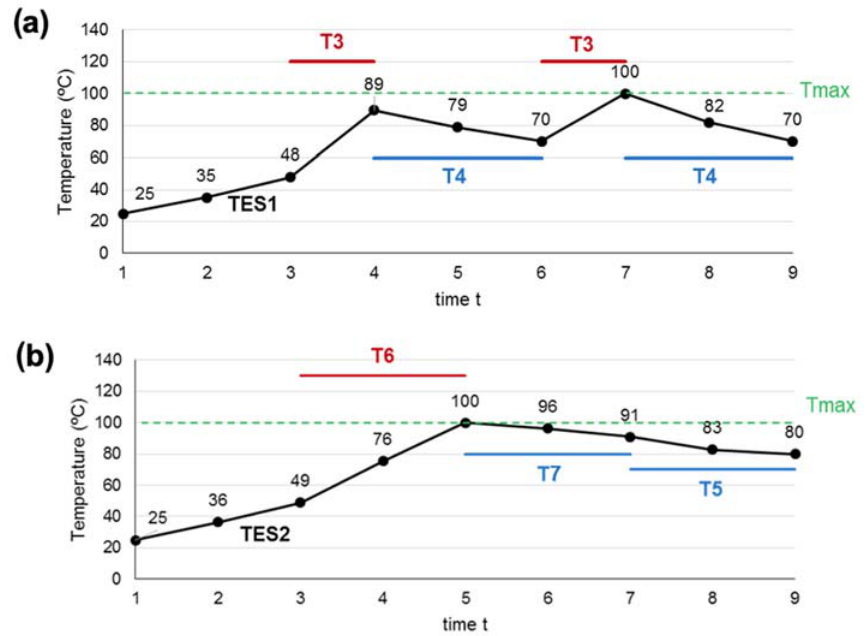
Figure 14. TES1 ( a ) and TES2 ( b ) temperature profiles.